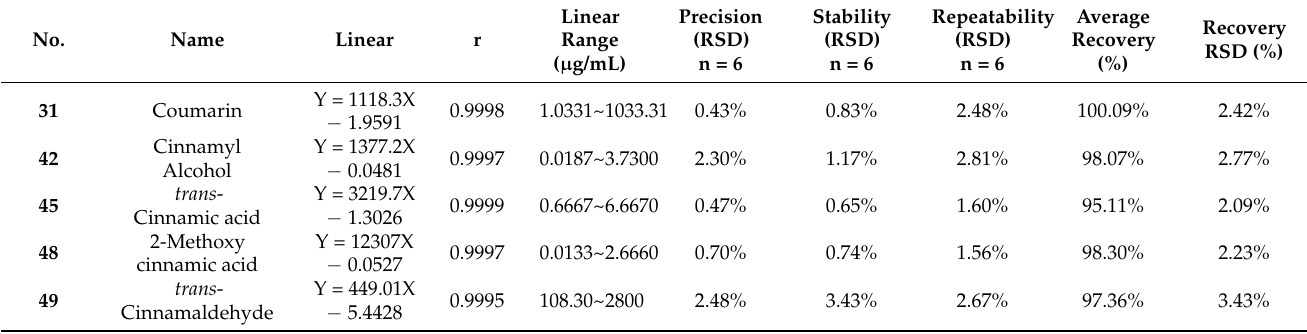
Table 2. Linear-regression data, precision, stability, and repeatability of five standard compounds.